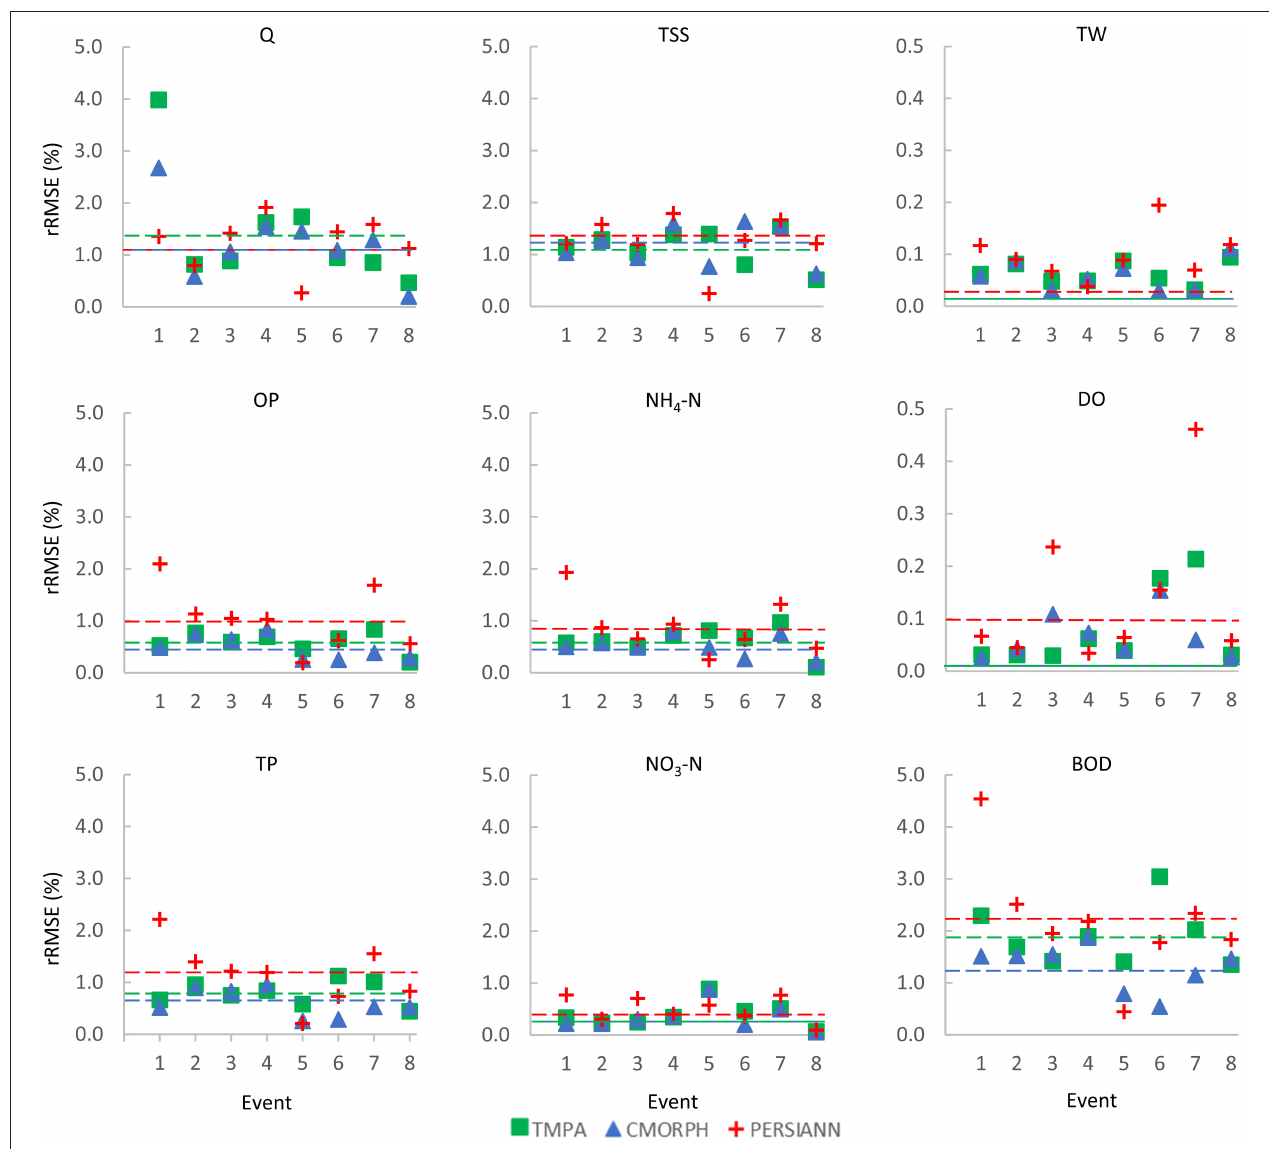
FIGURE 11 | rRMSEs of streamflow and water quality indicators between gauge-simulated and SPP-simulated output for TMPA, CMORPH, and PERSIANN for six evaluation points. The mean indicator value across all eight events is represented by a dashed line corresponding to TMPA, CMORPH, and PERSIANN in green, blue, and red,